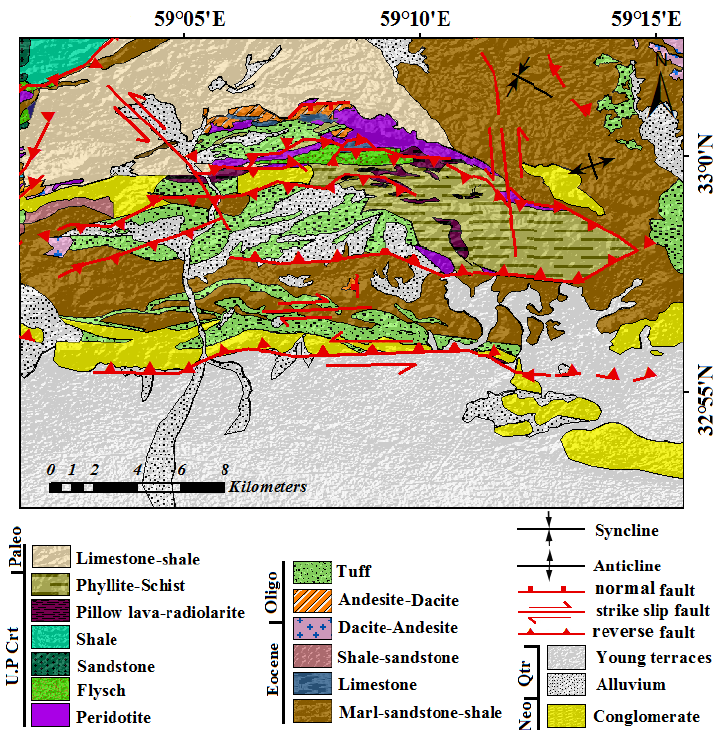
Figure 3. Digital elevation model structural map of the tectonic features. The orientation of the principal stress axes associated with faults is represented by stereonets.